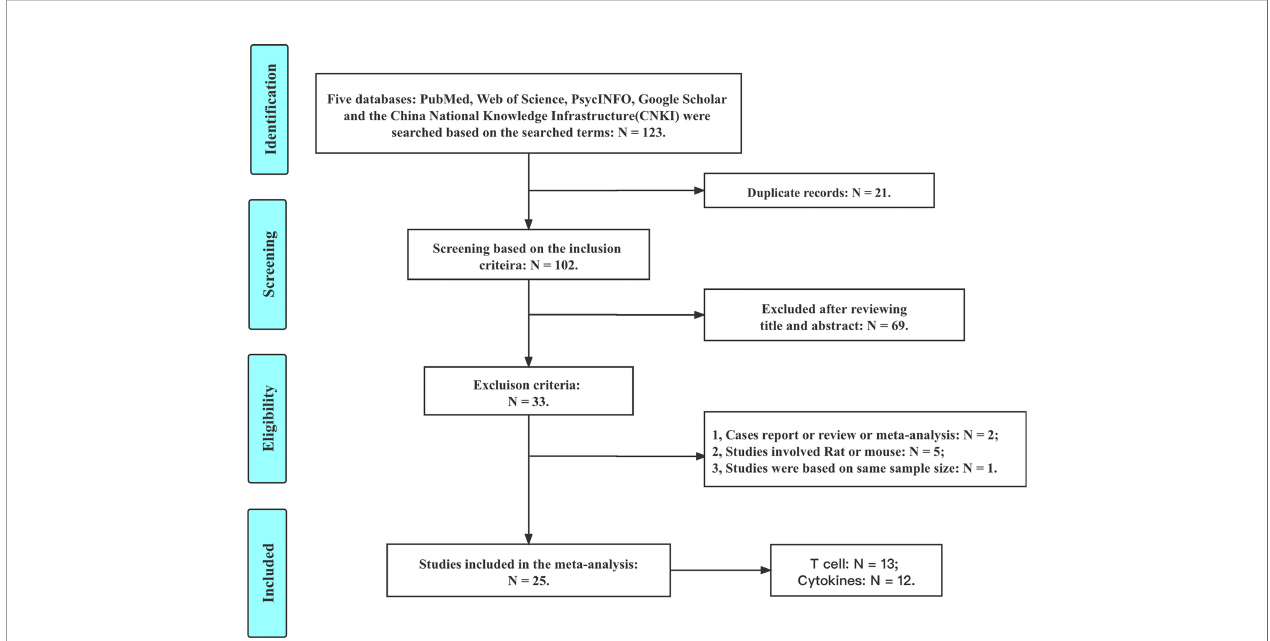
FIGURE 1 | Flowchart of the selection